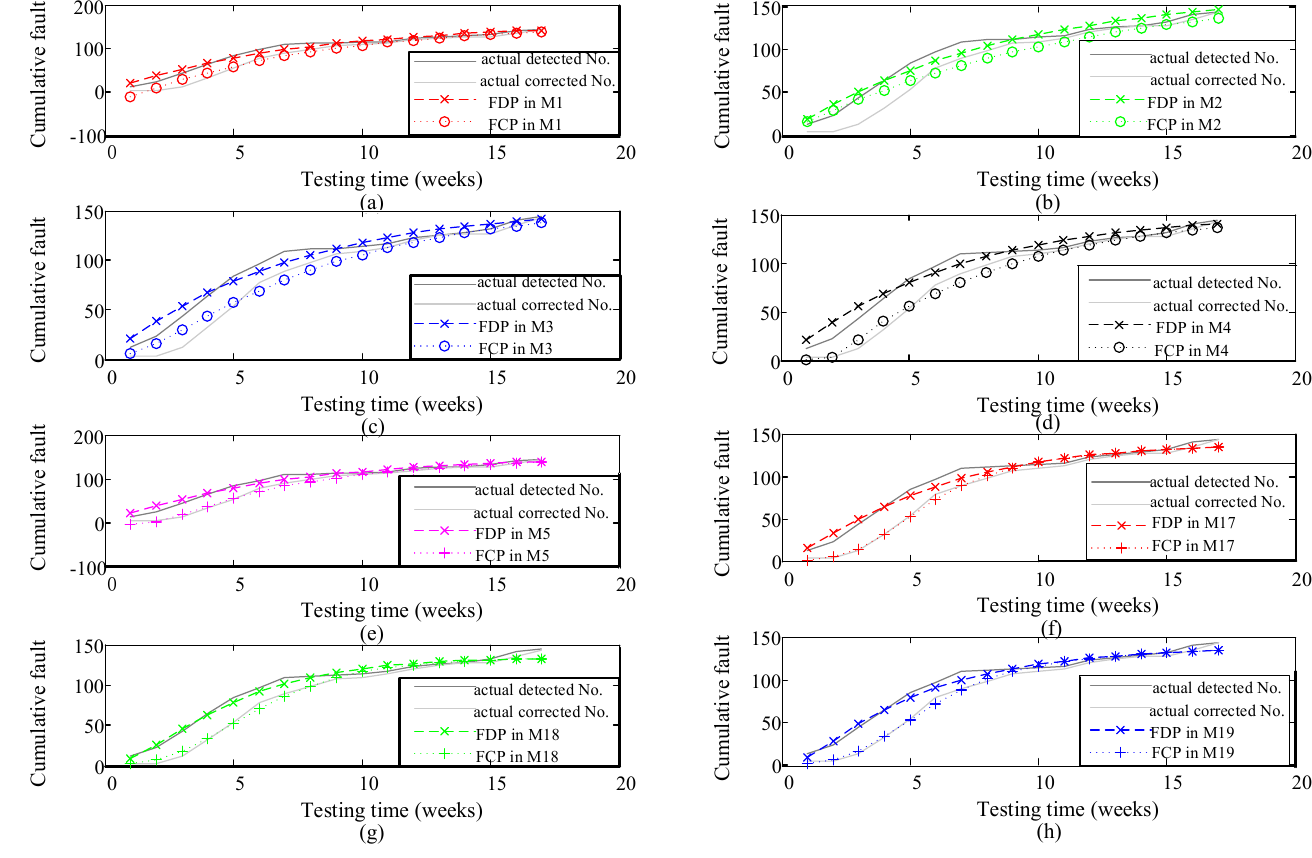
Figure 2. Comparisons of the fitting results based on M1-M5 and M17-M19 for DS-1 ( a – e ) FDP and FCP fitting results based on M1-M5 vs. actual detected faults and corrected fault number; ( f – h ) FDP and FCP fitting results based on M17-M19 vs. actual detected faults and corrected fault number.